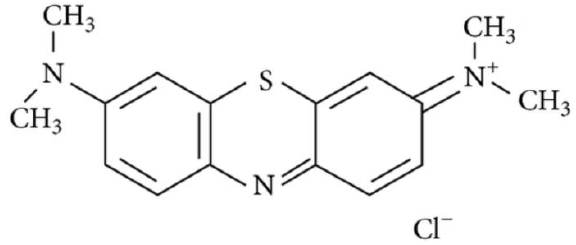
Figure 2. Chemical structure of methylene blue dye.